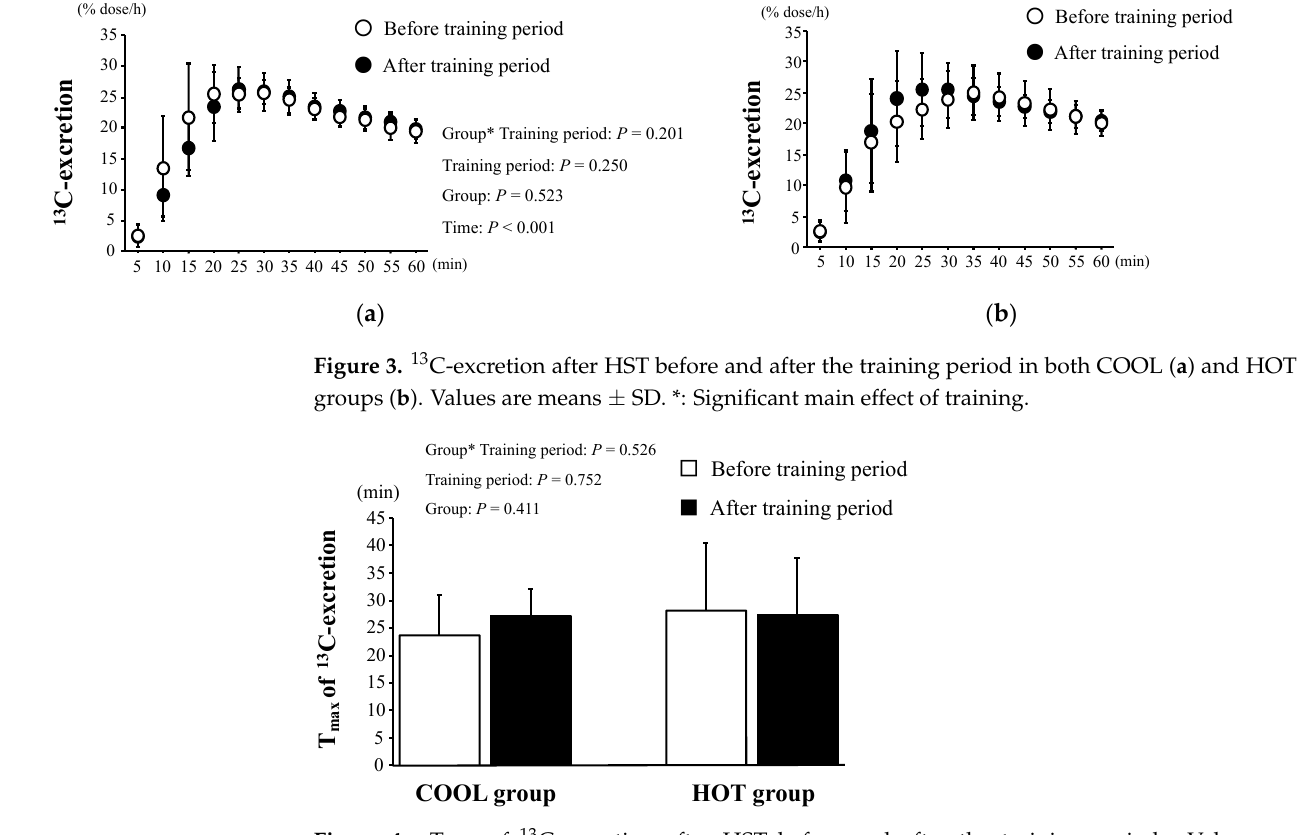
Figure 4. T max of 13 C-excretion after HST before and after the training period. Values are means ± SD. *: Significant main effect of